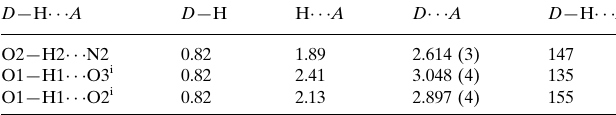
Hydrogen-bond geometry (A˚ , (cid:1)